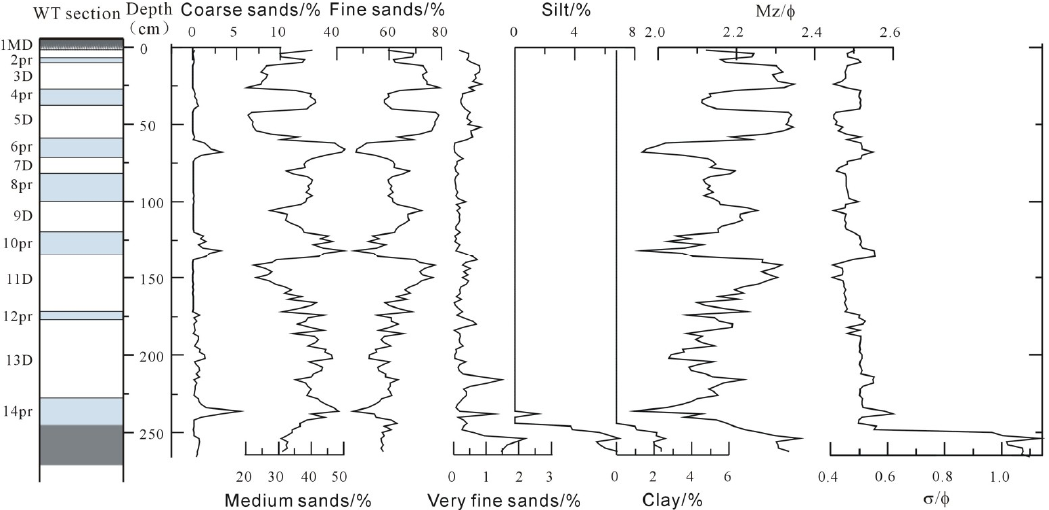
Figure 3. The percentage and parameters of grain-size distributions in the Wutou section.